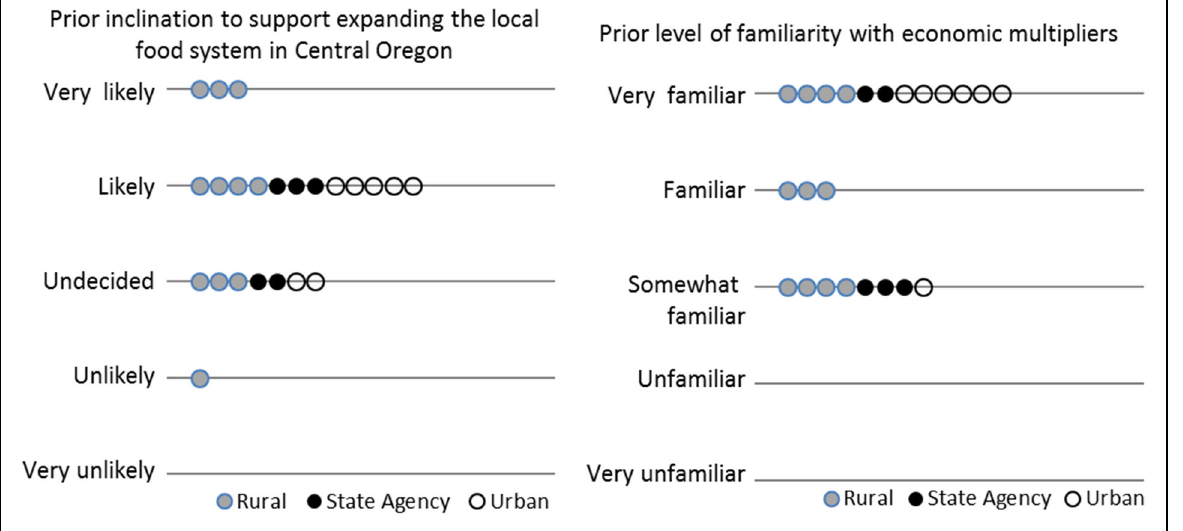
Figure 2. Responses to Survey Questions Regarding Expansion of Local Foods and Familiarity with Economic